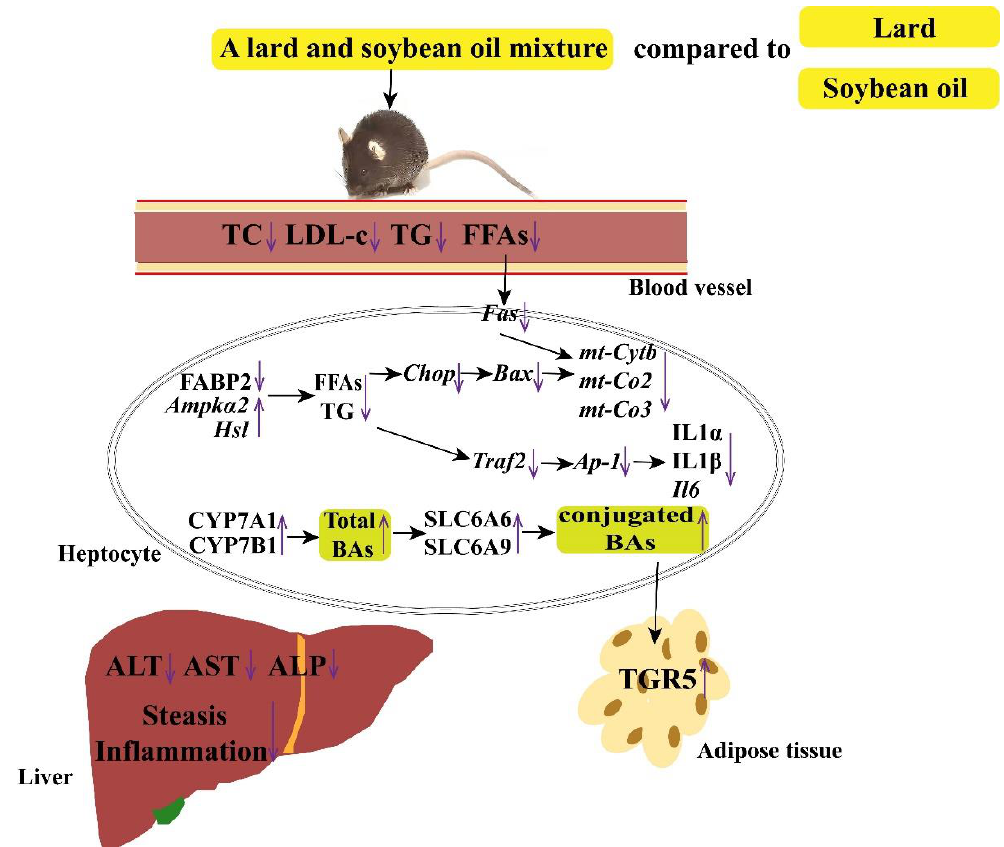
Figure 11. The mechanism of mixture of lard and soybean oil alleviates low-fat–high-carbohydrate diet-induced nonalcoholic fatty liver disease.